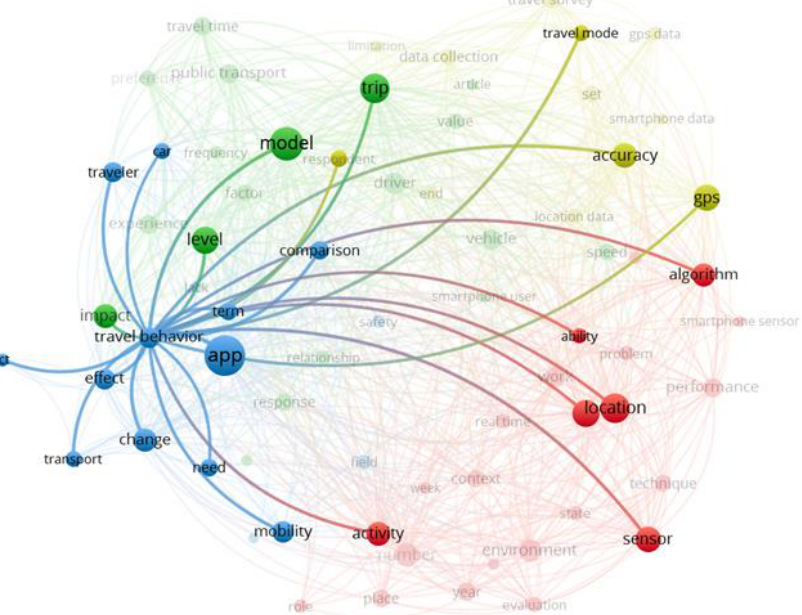
Figure 5. Co-occurrences of “ travel behavior ” . Source: VOSviewer.